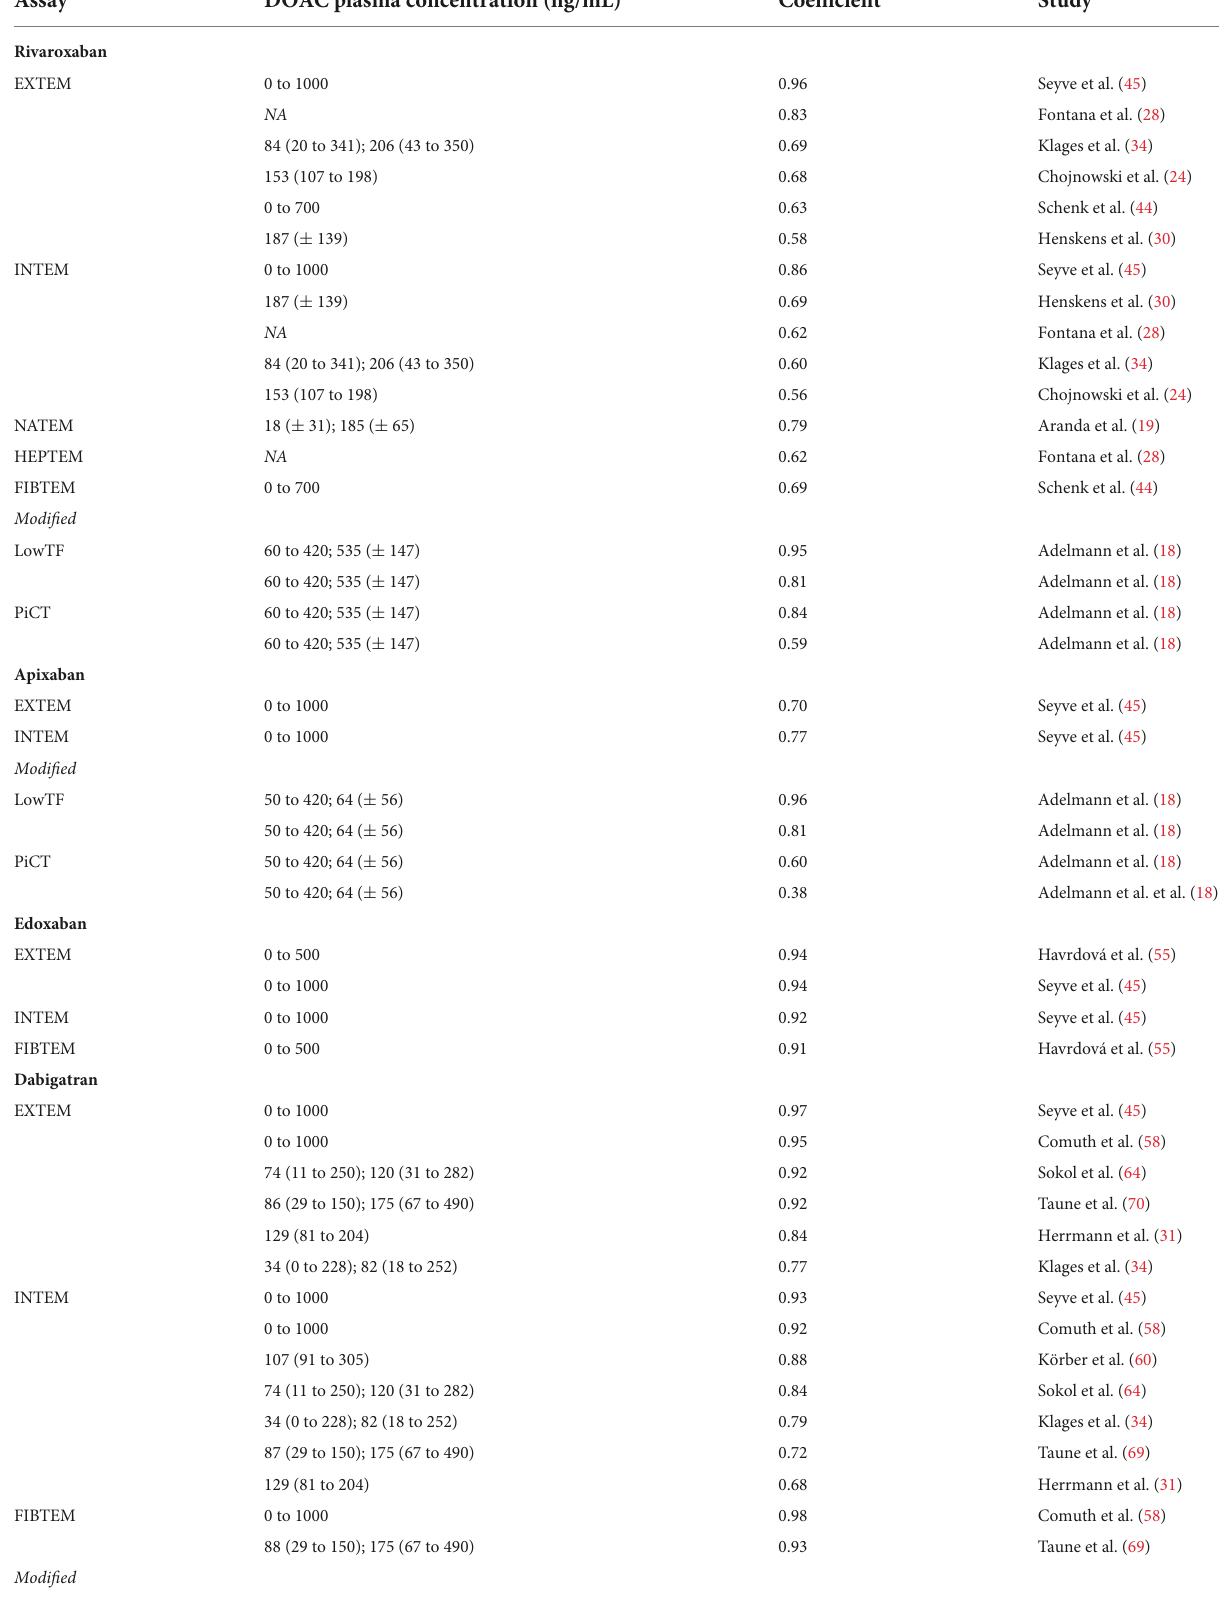
TABLE 2.1 Correlation of DOAC plasma concentration and ROTEM clotting time (CT) for different assays. Assay DOAC plasma concentration (ng/mL)